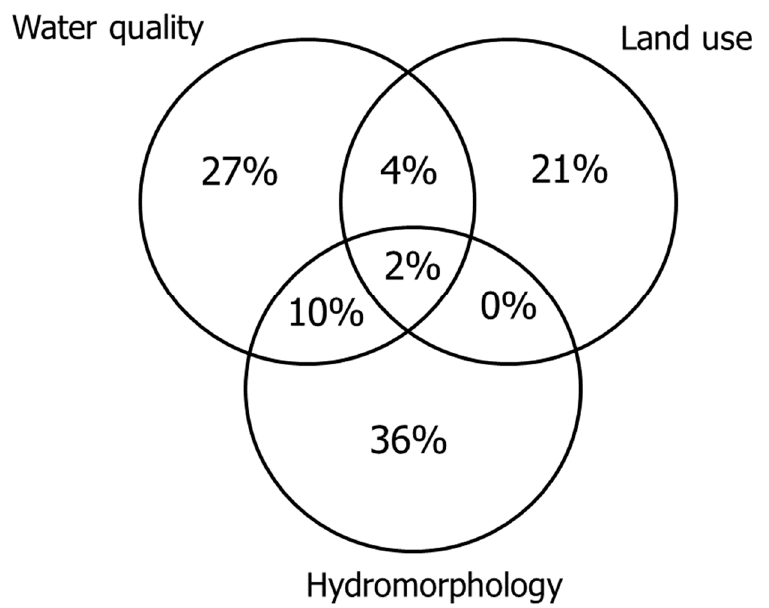
Figure 3. Venn diagram representing stressor-specific and joint effect contributions of the stressor variable groups to the explained variability of the benthic invertebrate assemblages. Explained variability is given as percentage of the total explained variance.